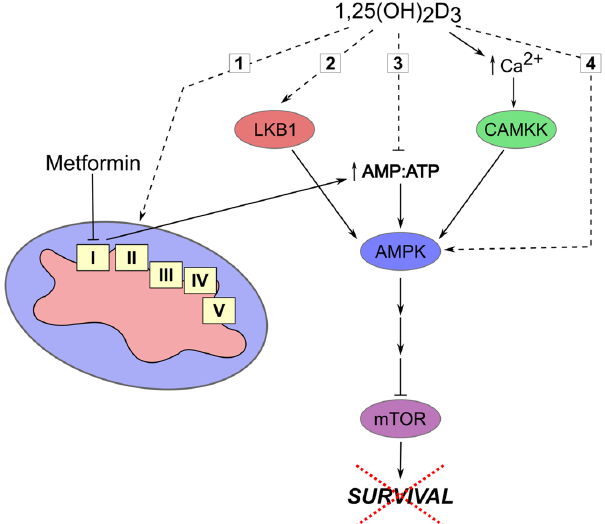
Figure 1. Dual targeting of AMPK signaling by 1,25(OH) 2 D 3 and metformin. Hypothesized mechanisms through which 1,25 ‐ dihydroxyvitamin D 3 (1,25(OH) 2 D 3 ) influences the activity of AMP ‐ activated protein kinase (AMPK) and hence cell survival are depicted by dashed lines and include: